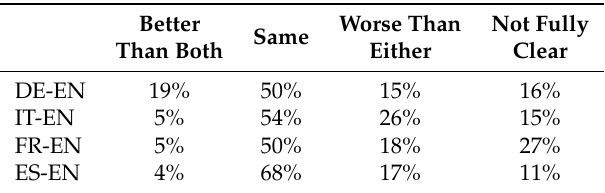
Table 8. Percentage of sentences translated by our systems which are adjudged to be better, worse or of the same quality compared to Google Translate and Bing Translator. Better Worse Than Not Fully Same Than Both